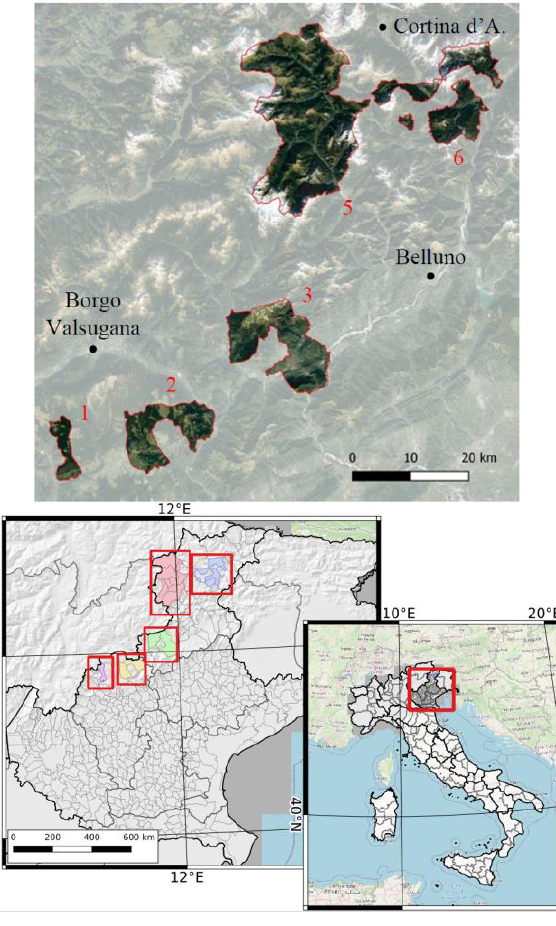
Figure 4 . Top part is detail of study areas surveyed with airborne laser scanner, bottom part is overview of areas in the Alpine